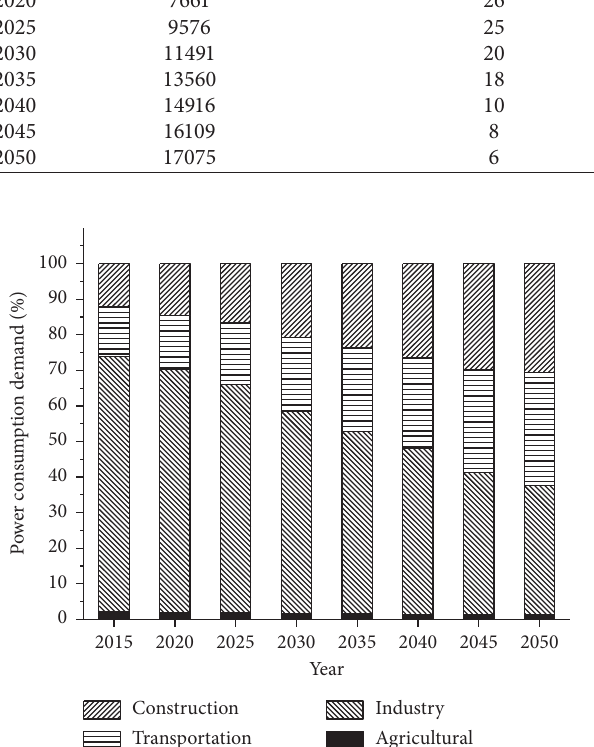
Figure 3: Power consumption demand of terminal departments.